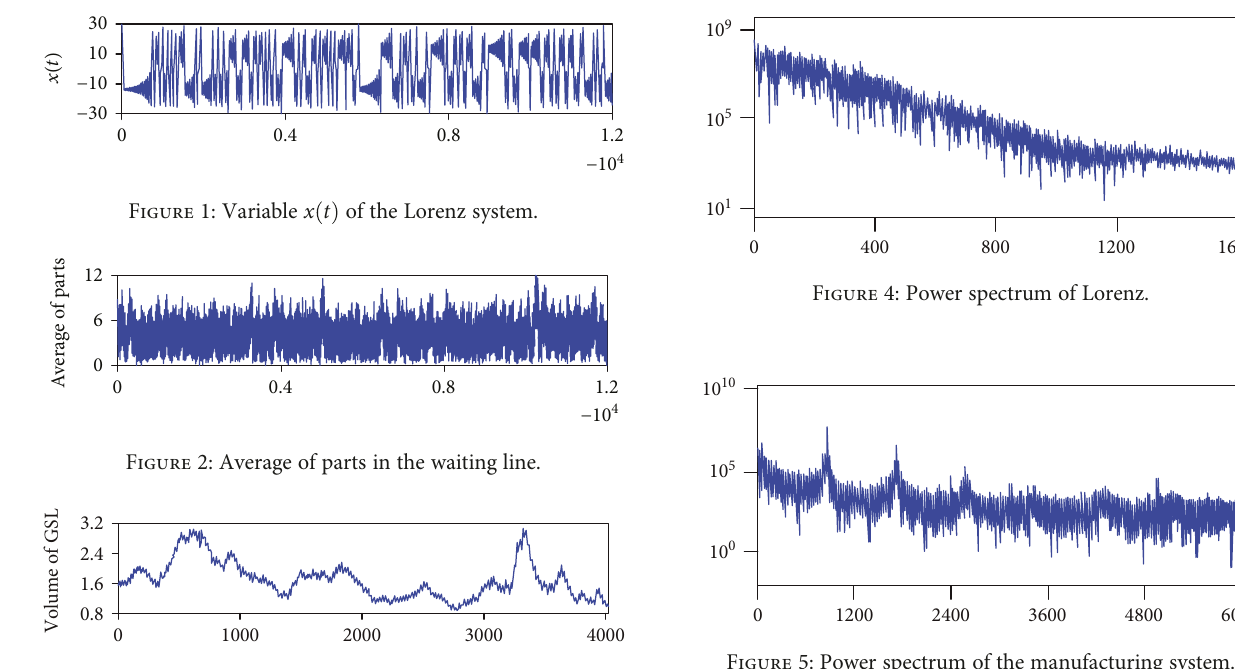
Figure 3: Volume of the Great Salt Lake (acre ∗ feet).